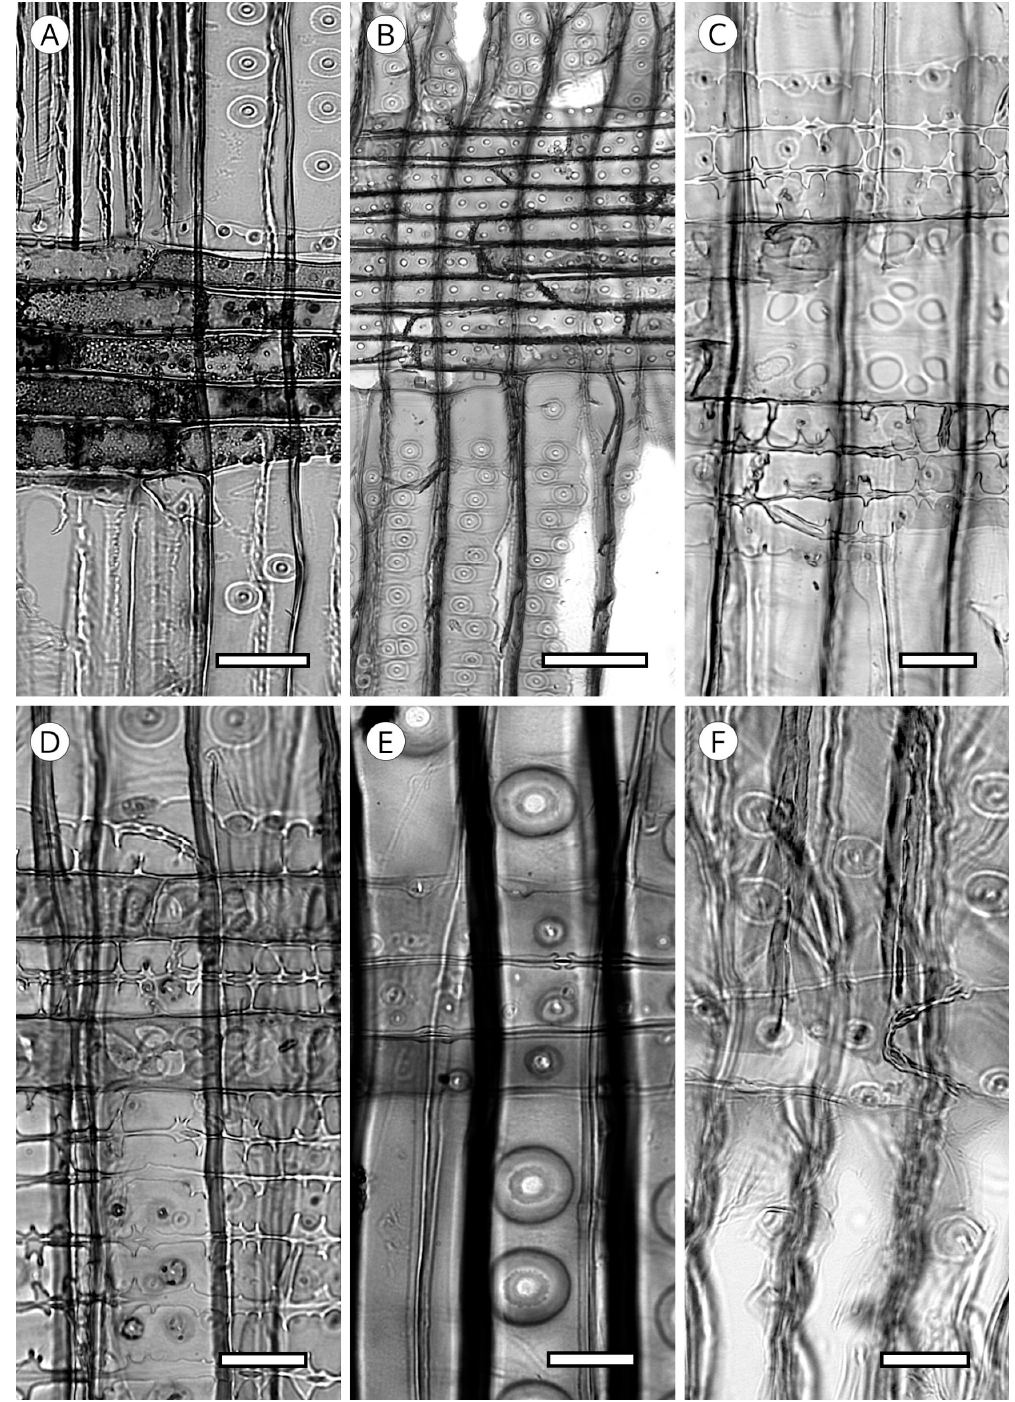
Figure 29. Ray composition. ( A ) Heterocellular ray composed of internal rows of ray parenchyma cells and marginal tracheids in Nothotsuga longibracteata (W.C.Cheng) H.H.Hu ex C.N.Page; ( B ) Homocellular ray composed solely of parenchyma cells in Keteleeria davidiana (C.E.Bertrand) Beissn.; ( C ) Heterocellular ray composed of ray tracheids in marginal rows in Pinus arizonica Engelm.; ( D ) Heterocellular ray composed of ray tracheids in alternate rows, both marginal and inside the ray in Pinus arizonica Engelm.; ( E ) Homocellular ray composed solely of ray tracheids in Pinus armandii Franch.; ( F ) Homocellular ray composed solely of compound ray tracheids in Callitropsis nootkatensis (D.Don) Oerst. Scale bars. ( A , B ) = 50 µ m; ( C – F ) = 25 µ